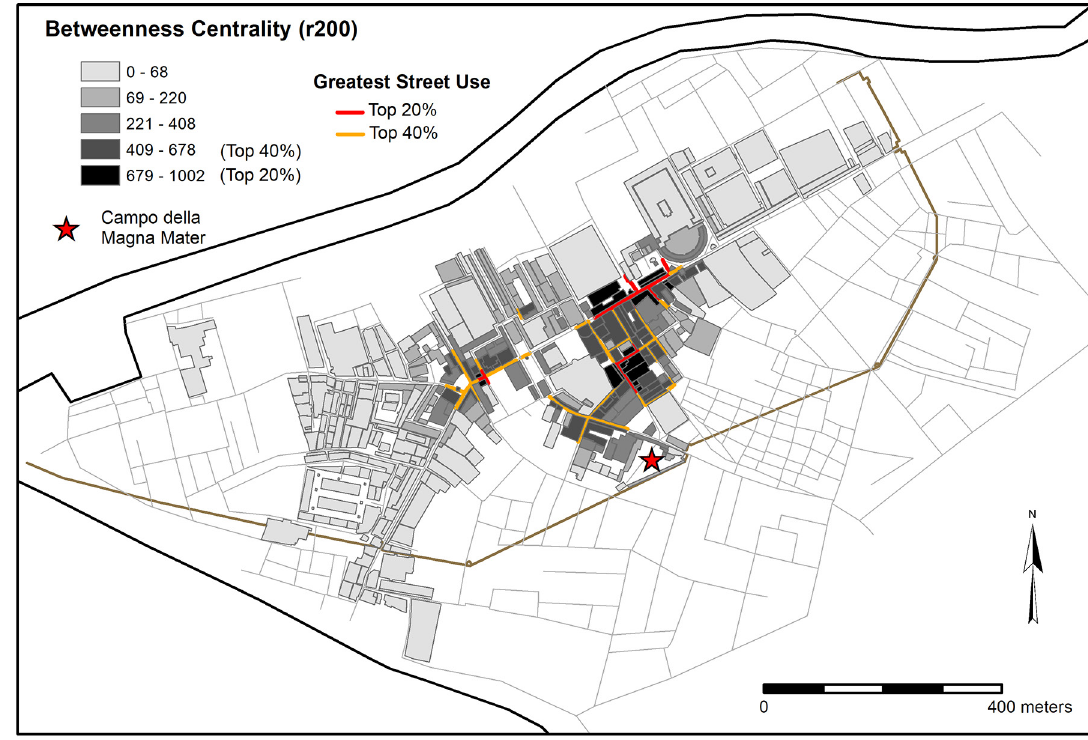
Figure 6. Map showing the calculation of betweenness centrality weighted by buildings within a 200 meter radius of the sanc- tuary. The streets following the two highest betweenness centrality metrics are designated in red and